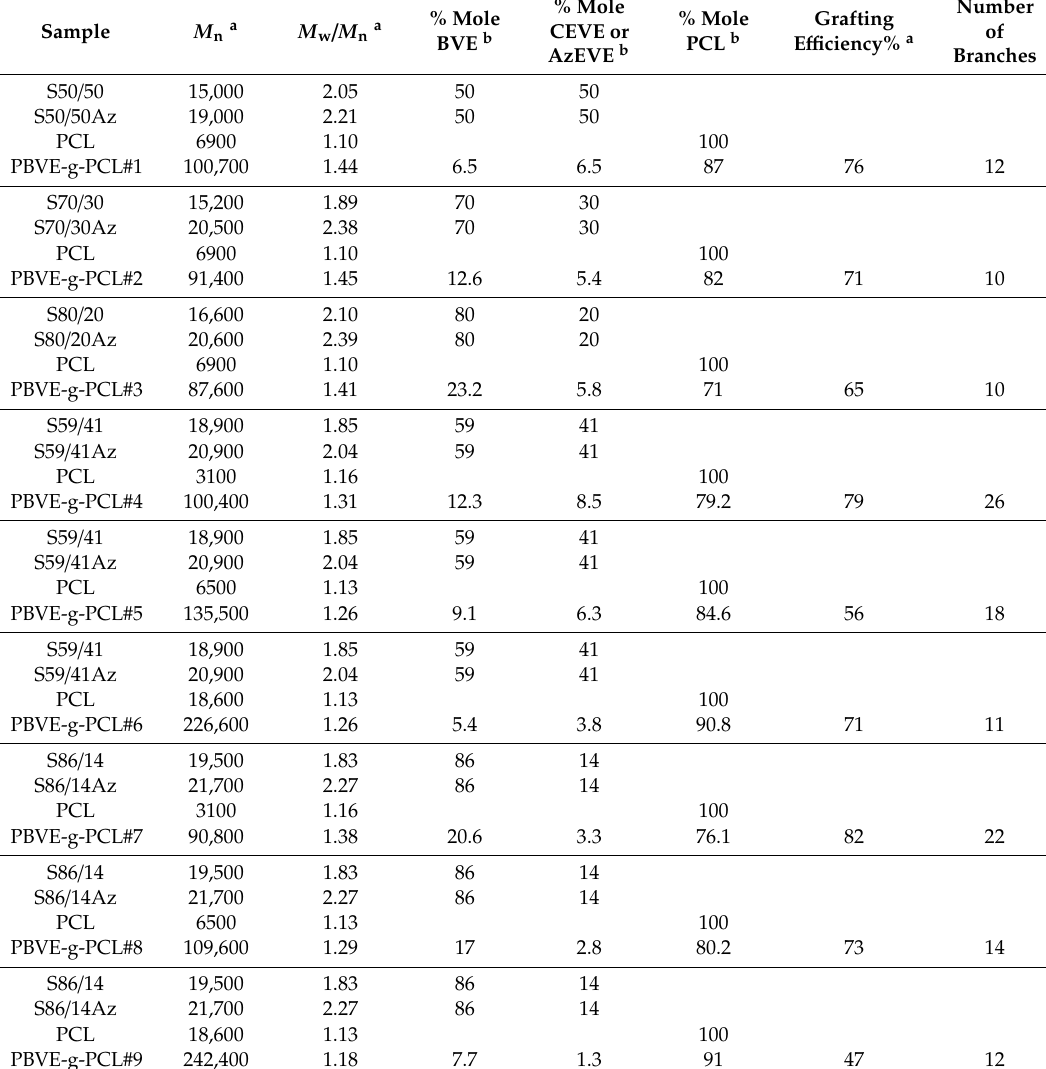
Table 5. Molecular characteristics of the graft copolymers PBVE– g –PCL prepared via the grafting “onto”